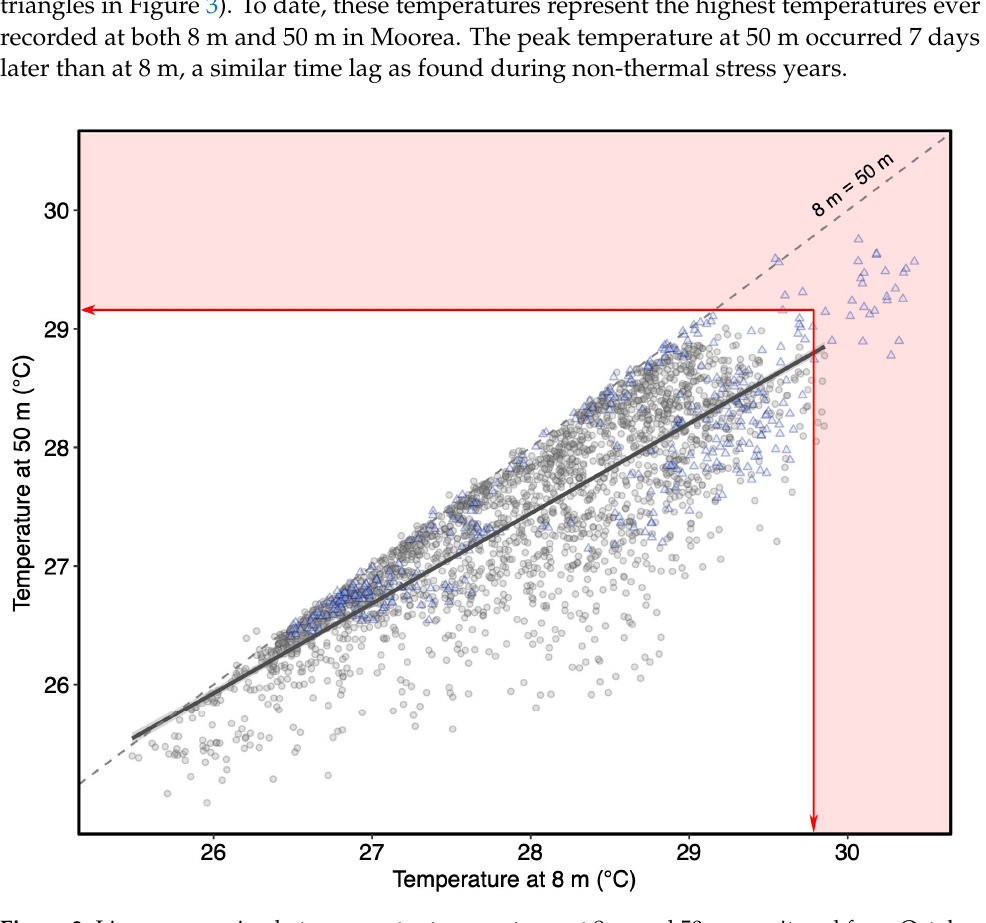
Figure 3. Linear regression between water temperatures at 8 m and 50 m monitored from October 2011 to April 2020 (grey-filled circles; excluding the years with thermal anomalies 2016 and 2019) on the coral reef outer slope in Moorea. Temperature recordings from October 2018 to September 2019 (during the marine heatwave and severe coral bleaching event in 2019) are shown with a blue triangle ( (cid:78) ). The red zone represents when the bleaching thresholds at each depth (shallow BT: 29.79 ◦ C; mesophotic BT: 29.16 ◦ C) were